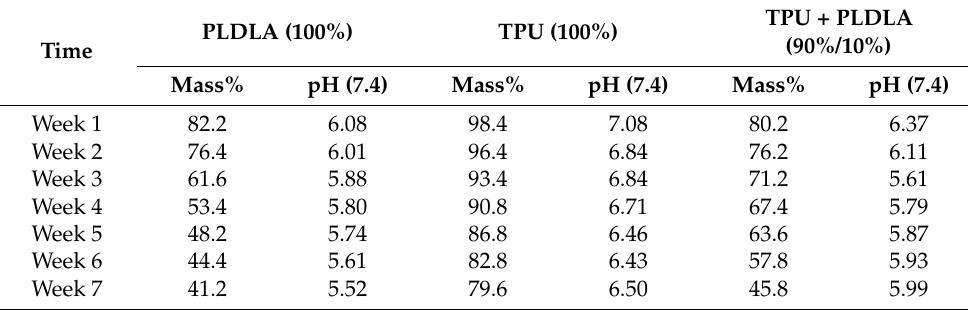
Table 2. The mean of mass and pH changes profile for the degradable polymer films.